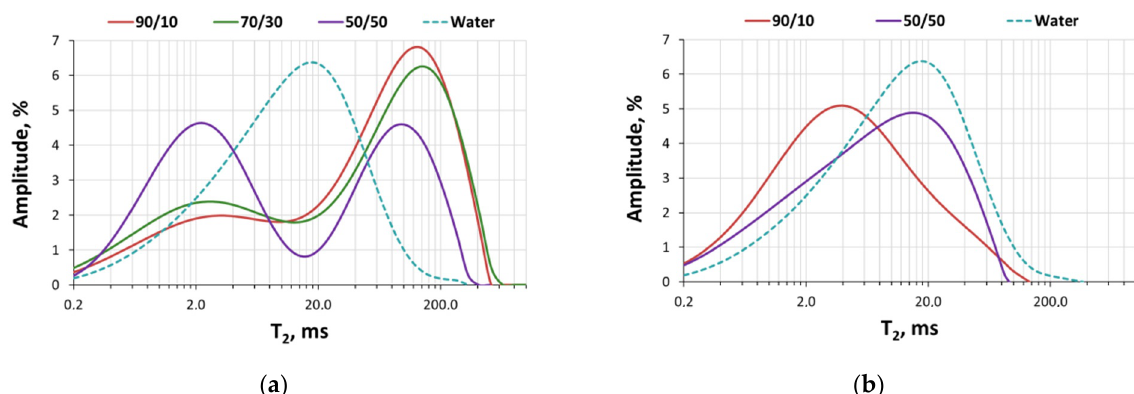
Figure 2. Transverse relaxation time spectra for the drill cuttings sampled from the 1010 m depth and saturated with water–oil mixtures: ( a ) based on oil C; ( b ) based on oil E.